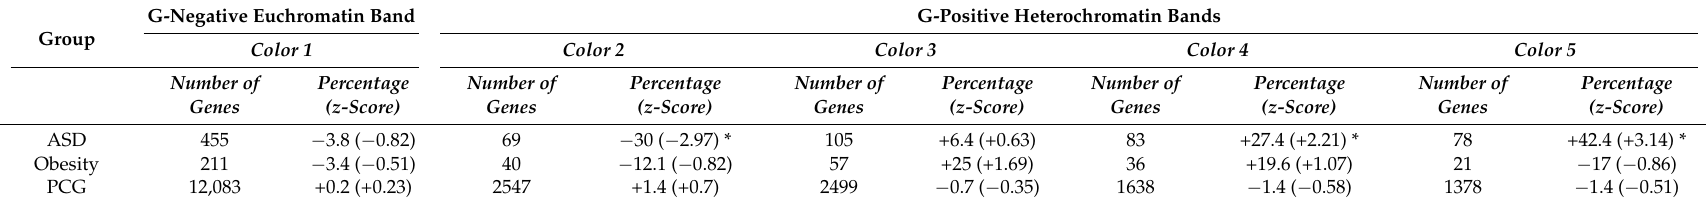
Table 4. Summary of the percentage deviation with standardized residuals (z-scores) for chromosome bands and genes by group and chromatin type.